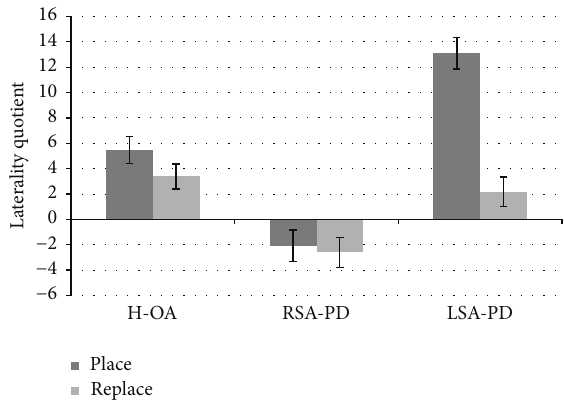
Figure 1: Laterality quotients computed from the GP revealed distinct differences between RSA-PD and LSA-PD groups compared to H-OAs. Error bars represent standard